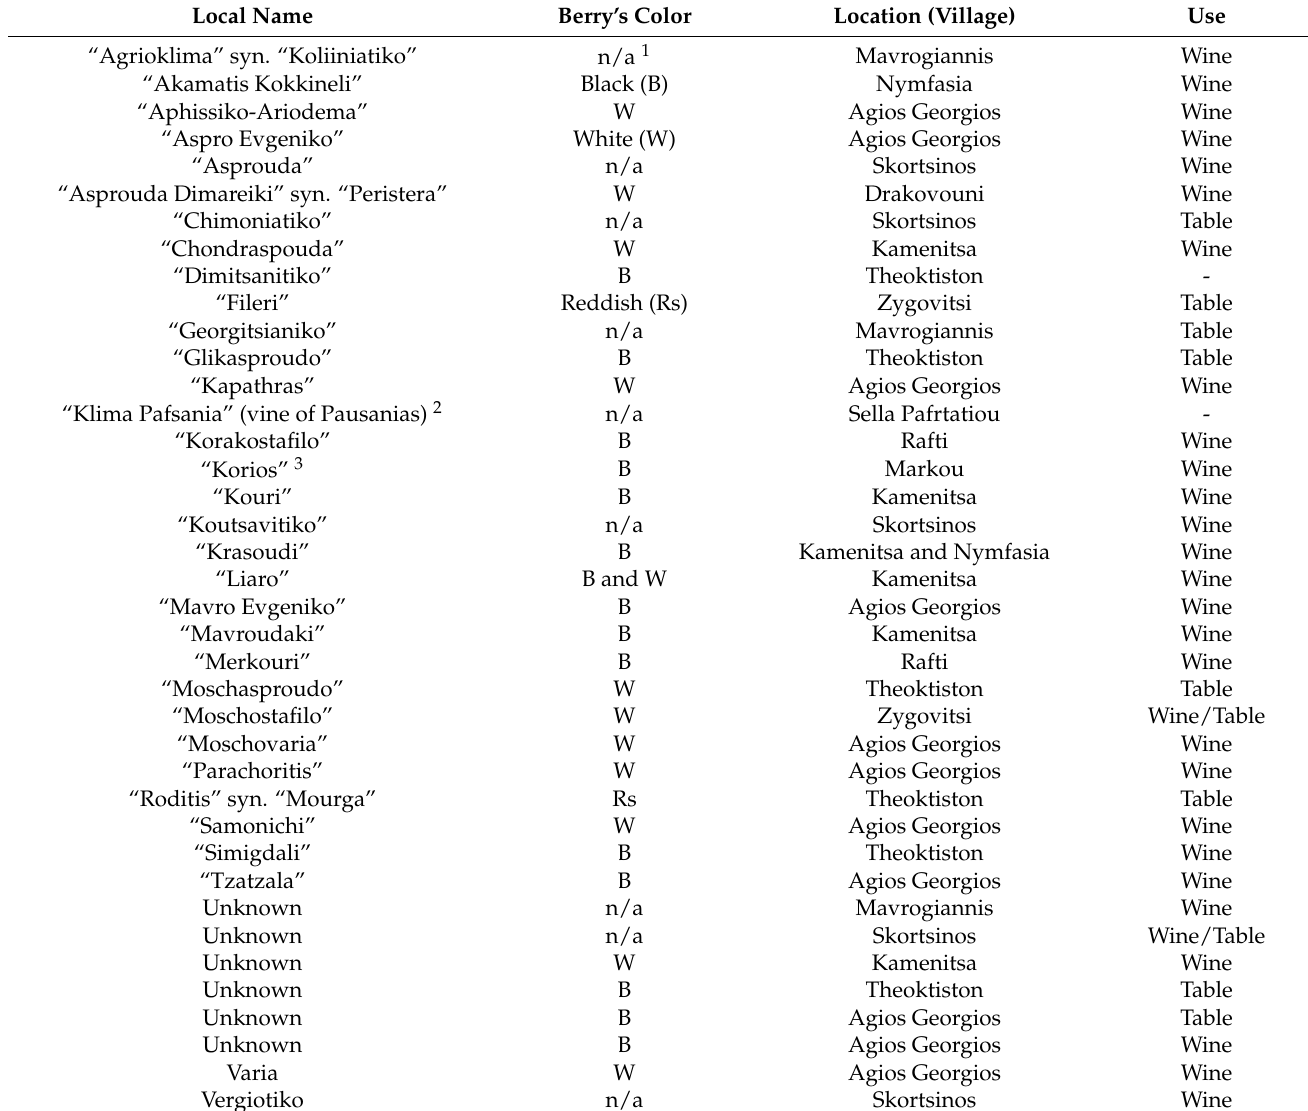
Table 6. The names of local grapevine varieties at villages in Arcadia collected during 1983 by V. Michos, Institute of